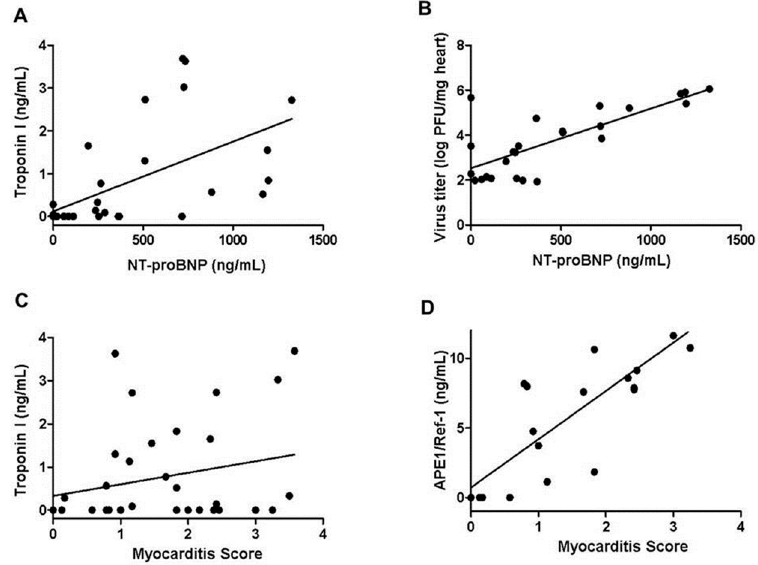
Figure 3. Relationship of serum troponin I, NT-proBNP, APE1/Ref-1, virus titers and myocardial inflammation. ( A ) Serum troponin I was positively correlated with serum NT-proBNP ( r = 0.586, p < 0.01); ( B ) Serum NT-proBNP showed positive association with virus titers ( r = 0.764, p < 0.01); ( C , D ) Both Serum troponin I and APE1/Ref-1 indicated positive correlations with the degree of inflammation, myocarditis score. Especially, serum APE1/Ref-1 demonstrated a stronger association ( r = 0.352, p < 0.05 in serum troponin I; r = 0.750, p < 0.01 in serum APE1/Ref-1). ( n = 5 in control; n = 10 in day 3; n = 10 in day 7; n = 7 in day 10).